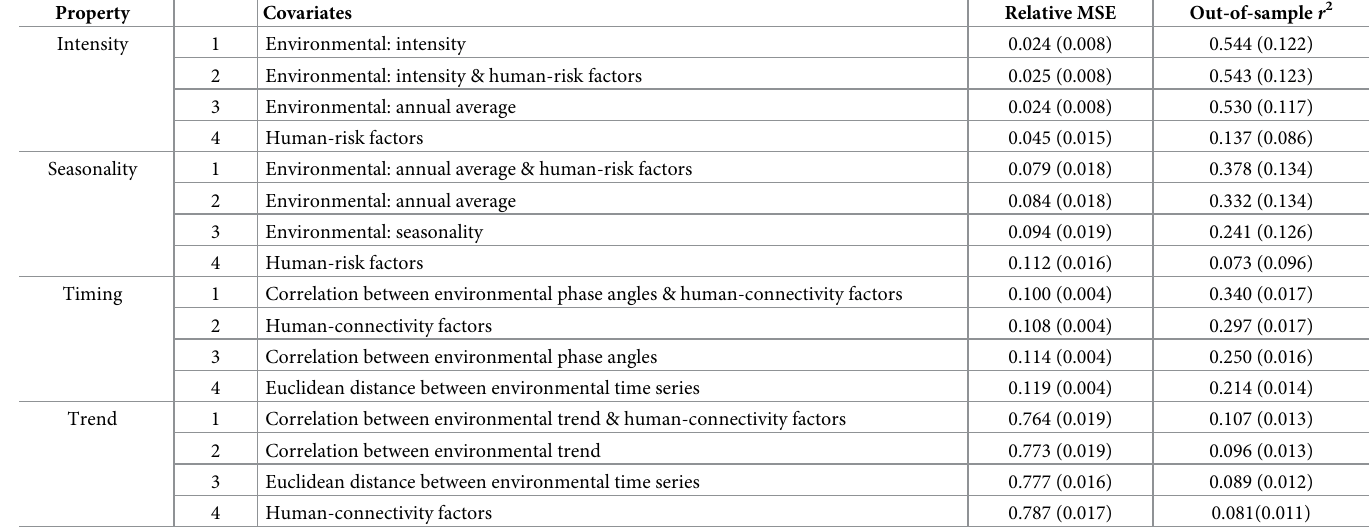
Table 3. Performance of outbreak property LASSO models. Models are listed in descending order of the mean out-of-sample correlation. The ranked order between the out-of-sample r 2 (higher indicates a better fit) and the relative MSE (lower indicates a better fit) is not exact. Standard deviation of the 100 model fits are listed in